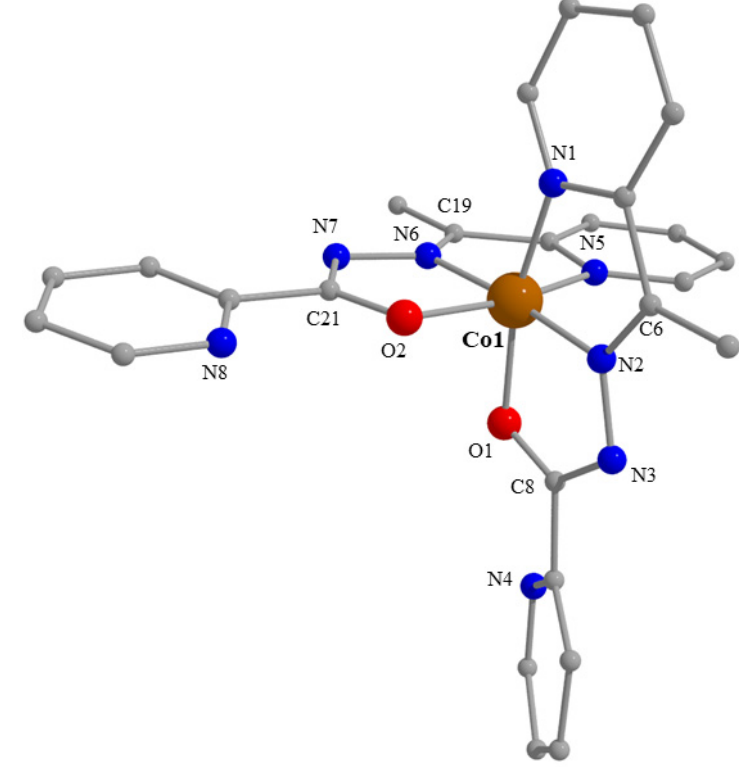
Figure 5. Partially labelled plot of the structure of the cation [Co(L) 2 ] + that is present in the crystal structure of 4 . A plot with thermal ellipsoids is presented in Figure S20.